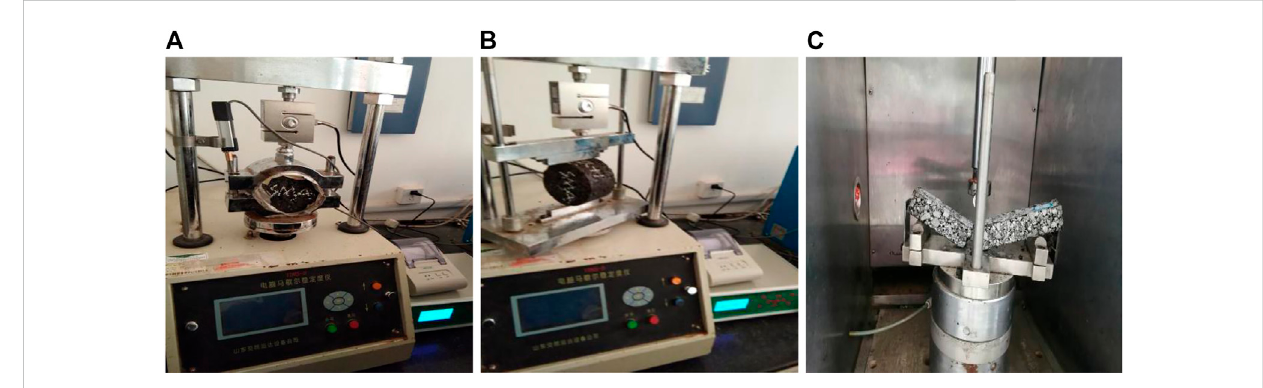
FIGURE 2 In-service performance assessment test, (A) Marshall test, (B) freeze-thaw splitting test, (C) low-temperature bending test.